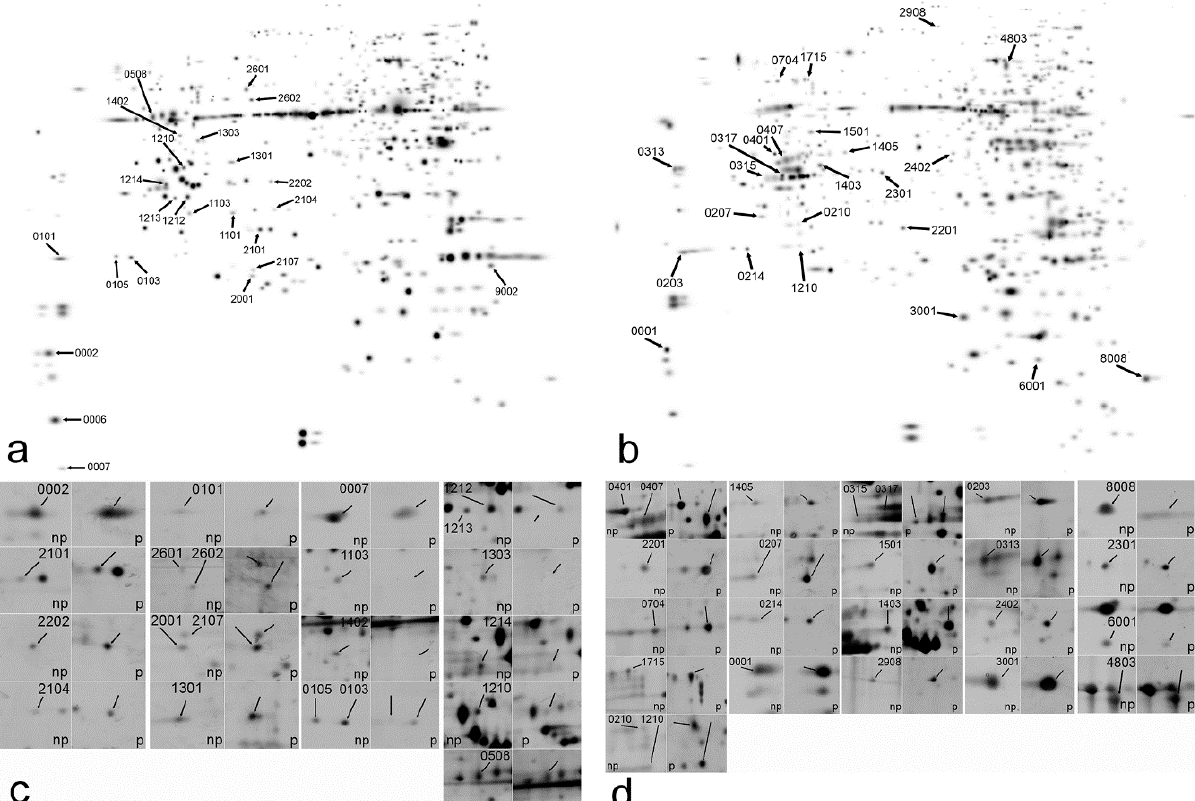
Figure 2. PDQuest master gel images of 2D-electrophoregrams of Arabidopsis leaves ( a ) and stem ( b ) and the respective differentially regulated protein spots ( c , d ). Arabidopsis was either parasitized (p) or non-parasitized (np) by Cuscuta australis . Protein spot numbers correspond to the assigned by PDQuest.